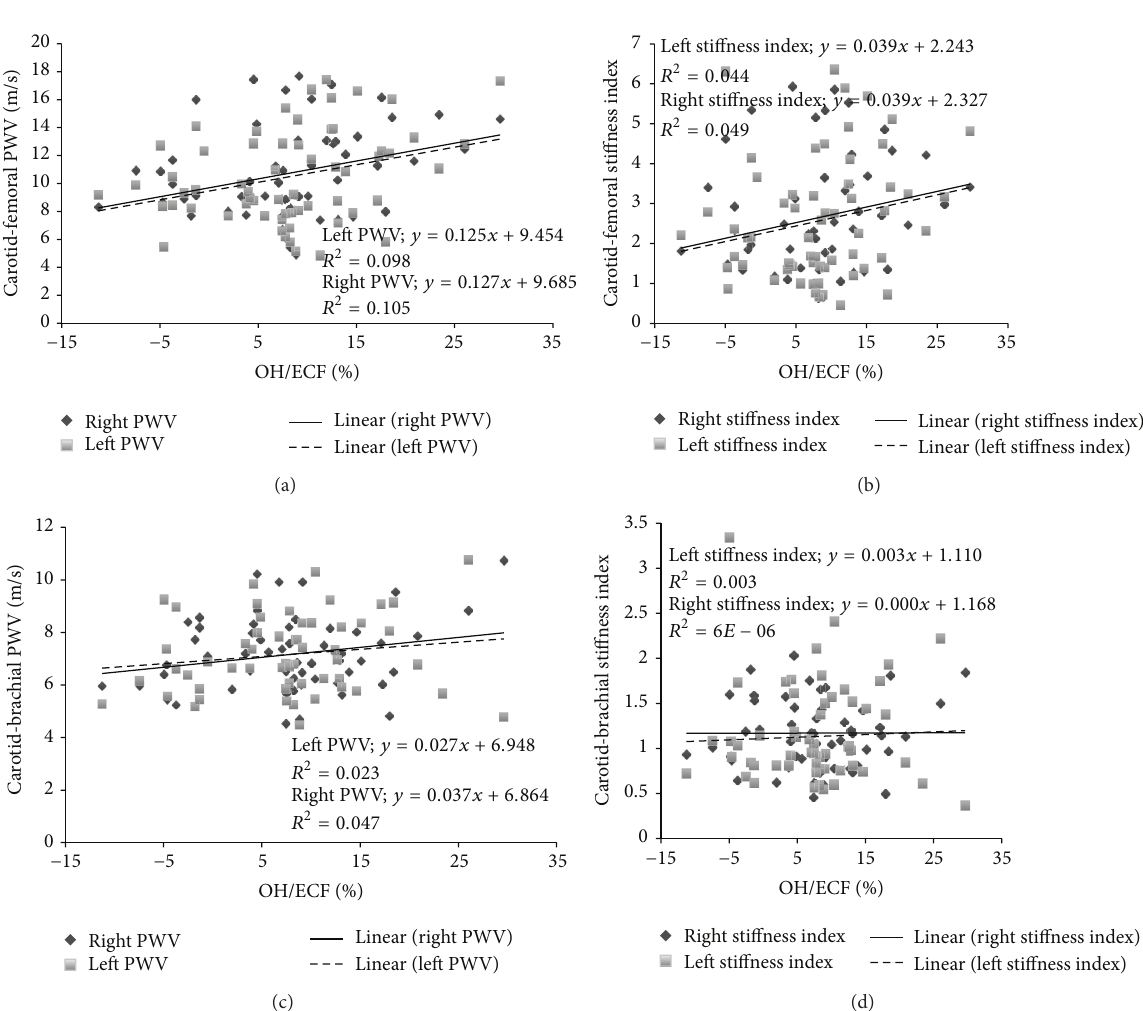
(“MExF”) as a function of ECF, ICF, and weight. A few